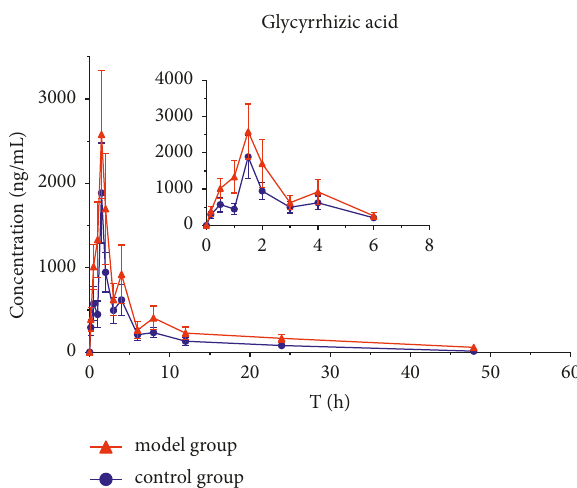
Figure 6: Concentration-time profiles of glycyrrhizic acid after HQD administration ( x ± SD, n � 8).